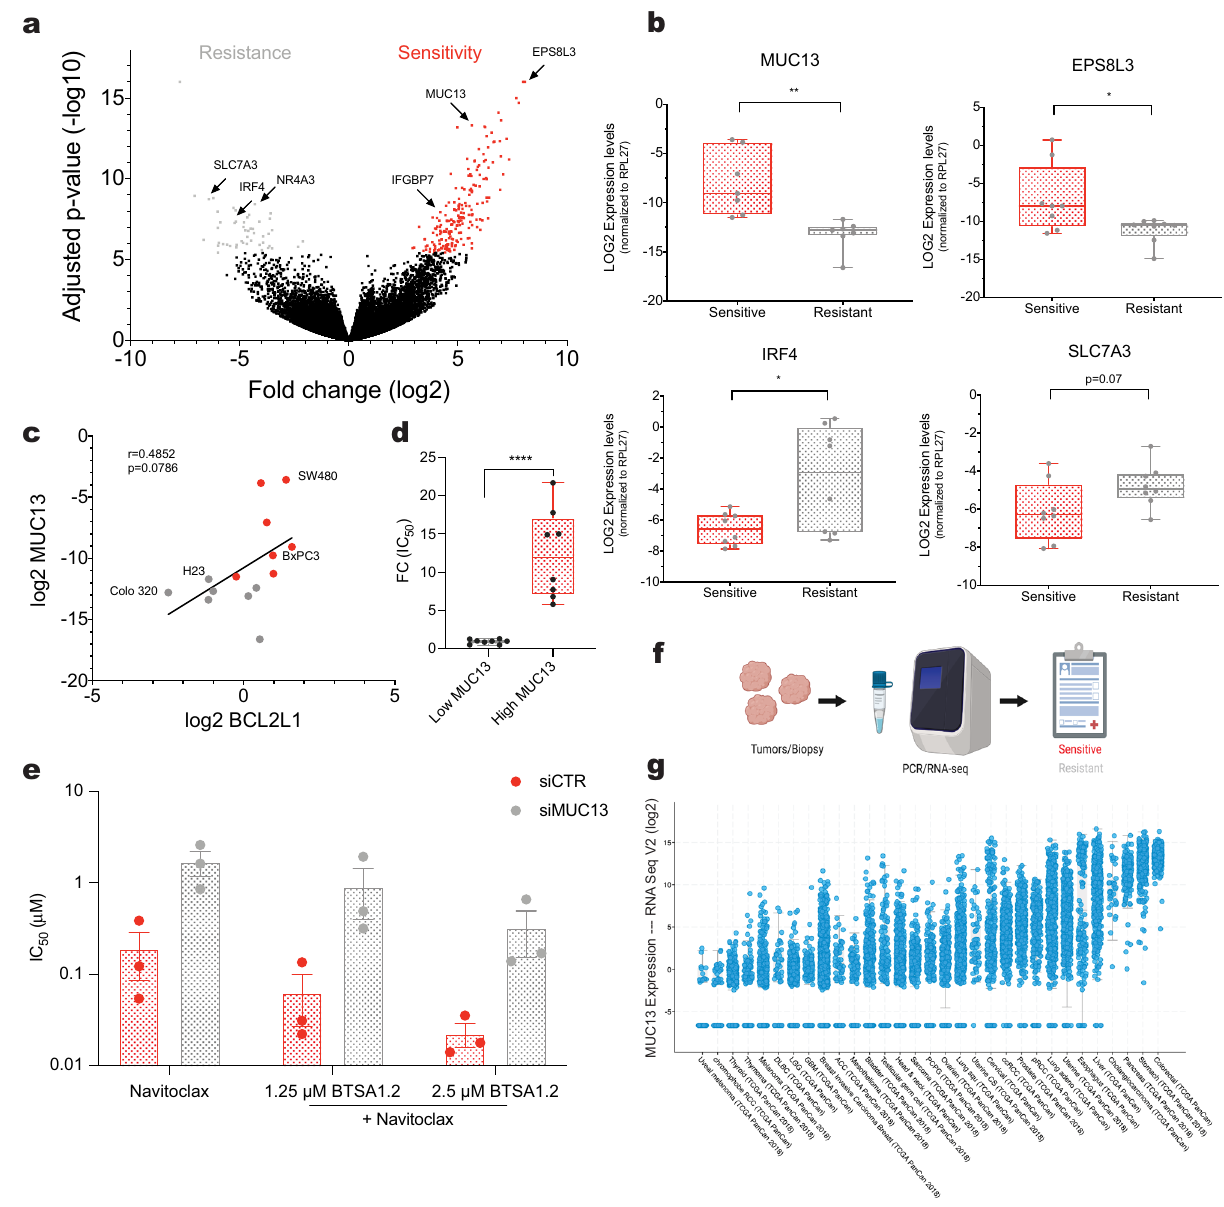
Fig. 7 Bioinformatic analysis predicts markers of sensitivity and resistance to the BTSA1.2 and Navitoclax combination. a Volcano plot showing the expression change and signi fi cance level of genes between sensitive and resistant cell lines as de fi ned based on the IC 50 change from Navitoclax alone to BTSA1.2 and Navitoclax combination (corresponding to Fig. 2b). Top 250 predicted markers of sensitivity (red) and resistance (gray) are highlighted. b Box plot of validation of top hits associated with sensitivity and resistance to the BTSA1.2 and Navitoclax combination (corresponding to Fig. 2b) by RT-qPCR. Relative gene expression was normalized using RPL27. Analysis done in 7 sensitive cell lines and 6 resistant cell lines. The lines within the boxes show the median expression values, the box denotes the IQR, while the whiskers indicate maxima and minima values. Data are mean ± SD from n = 3 independent experiments. Statistics were obtained using two-tailed student t-test: * p < 0.05; ** p < 0.01; *** p < 0.001; **** p < 0.0001. c Correlation of BCL2L1 ( refers to BCL-XL protein ) relative gene expression levels and MUC13 gene expression levels in cell lines categorized as sensitive or resistant to the BTSA1.2 and Navitoclax combination (corresponding to Fig. 2b) using Pearson-Correlation. d Box plot of MUC13 expression grouped by the sensitivity to the BTSA1.2 and Navitoclax combination (corresponding to Fig. 2b). The lines within the boxes show the median MUC13 expression values, the box denotes the IQR, while the whiskers indicate maxima and minima values. Data are mean ± SD from n = 8 independent experiments. Statistics were obtained using two-tailed student t-test: * p < 0.05; ** p < 0.01; *** p < 0.001; **** p < 0.0001. e Bar graph plot of the cell viability IC 50 ( μ M) of SW480 after transfection with siRNA CTR or siRNA MUC13 and treated for 24 h with Navitoclax in combination with a constant sensitizing concentration of BTSA1.2 (loss of cell viability <20%). Data are mean ± SD from n = 3 independent experiments. f Schematic of various tumors analyzed for gene expression to predict sensitivity to the BTSA1.2 and Navitoclax combination. g MUC13 cancer patient ’ s expression data using TCGA and other non-redundant data from cbioportal.org. Statistics were obtained using student t -test: * p < 0.05; ** p < 0.01; *** p < 0.001; **** p < 0.0001. Source data are provided as a Source Data fi